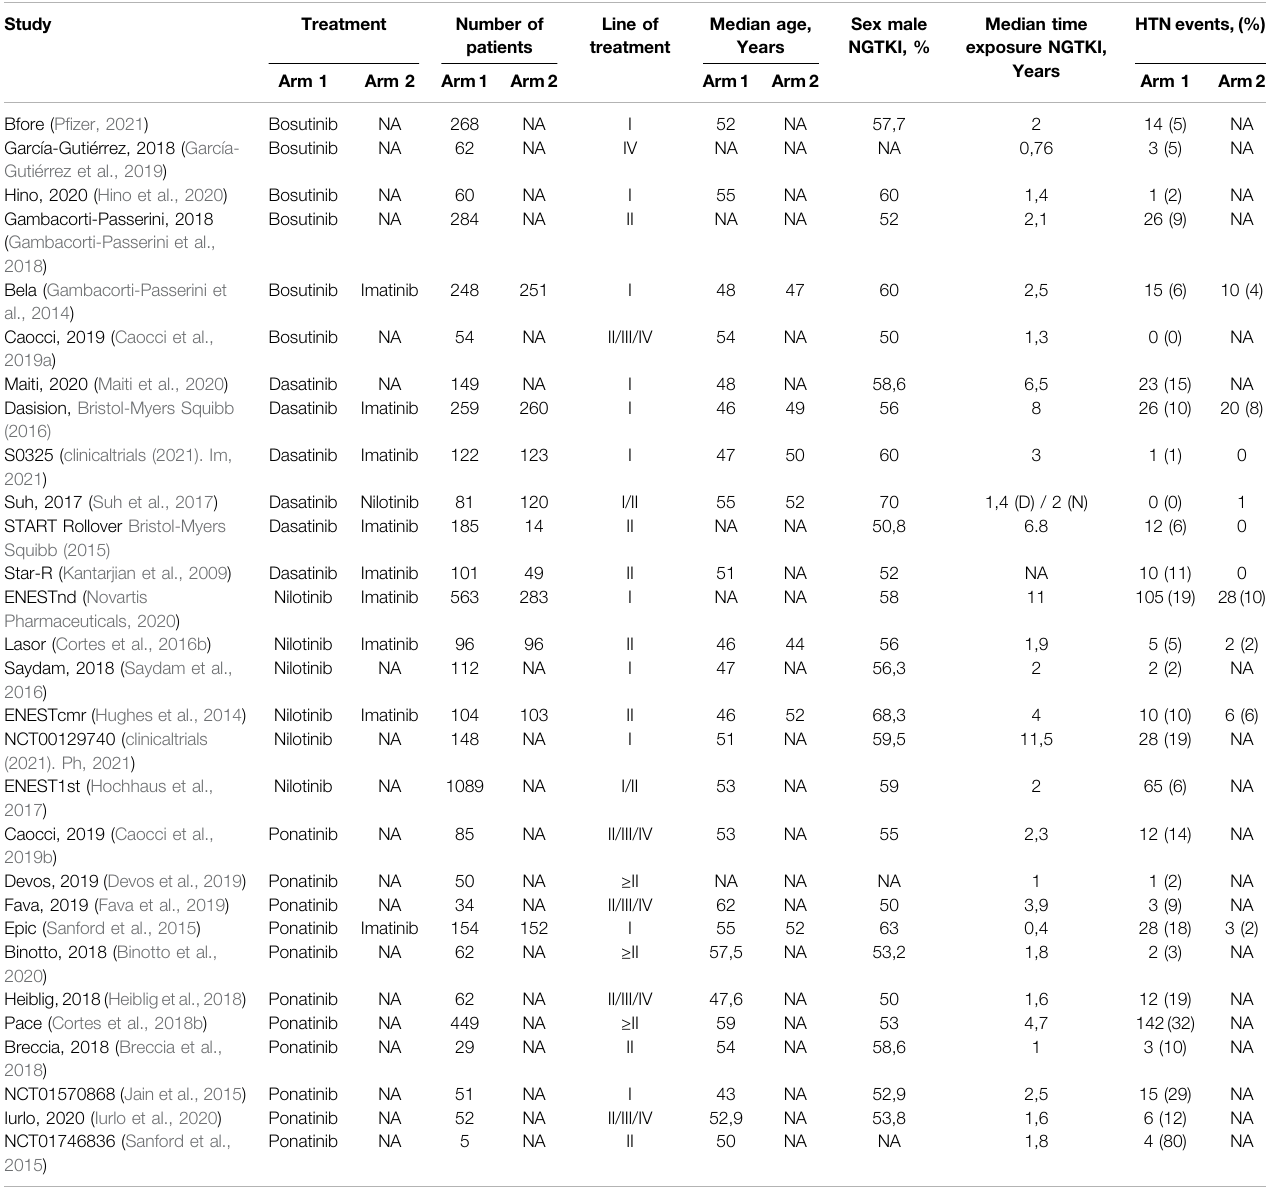
TABLE 1 | Characteristics of the studies